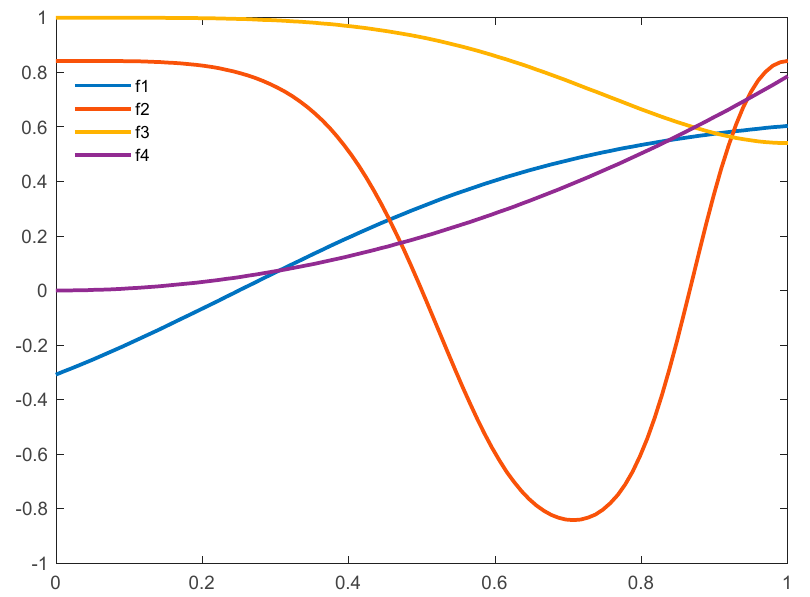
Figure 2. An illustration of four distinctive coefficient generation functions defined in Equations (19)–(22) (where x axis denotes a randomly generated value between 0 and 1, while y axis signifies f s as defined in Equation (14)).